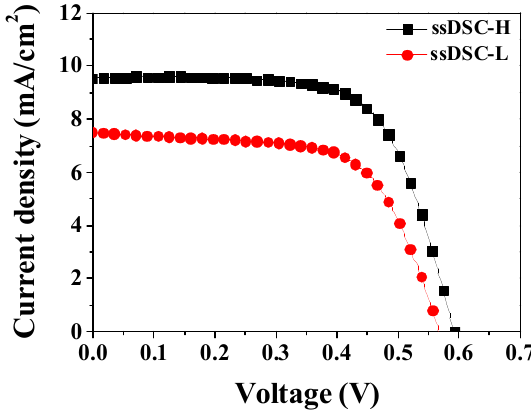
Figure 3. J – V characteristics of the ssDSC-H and the ssDSC-L.